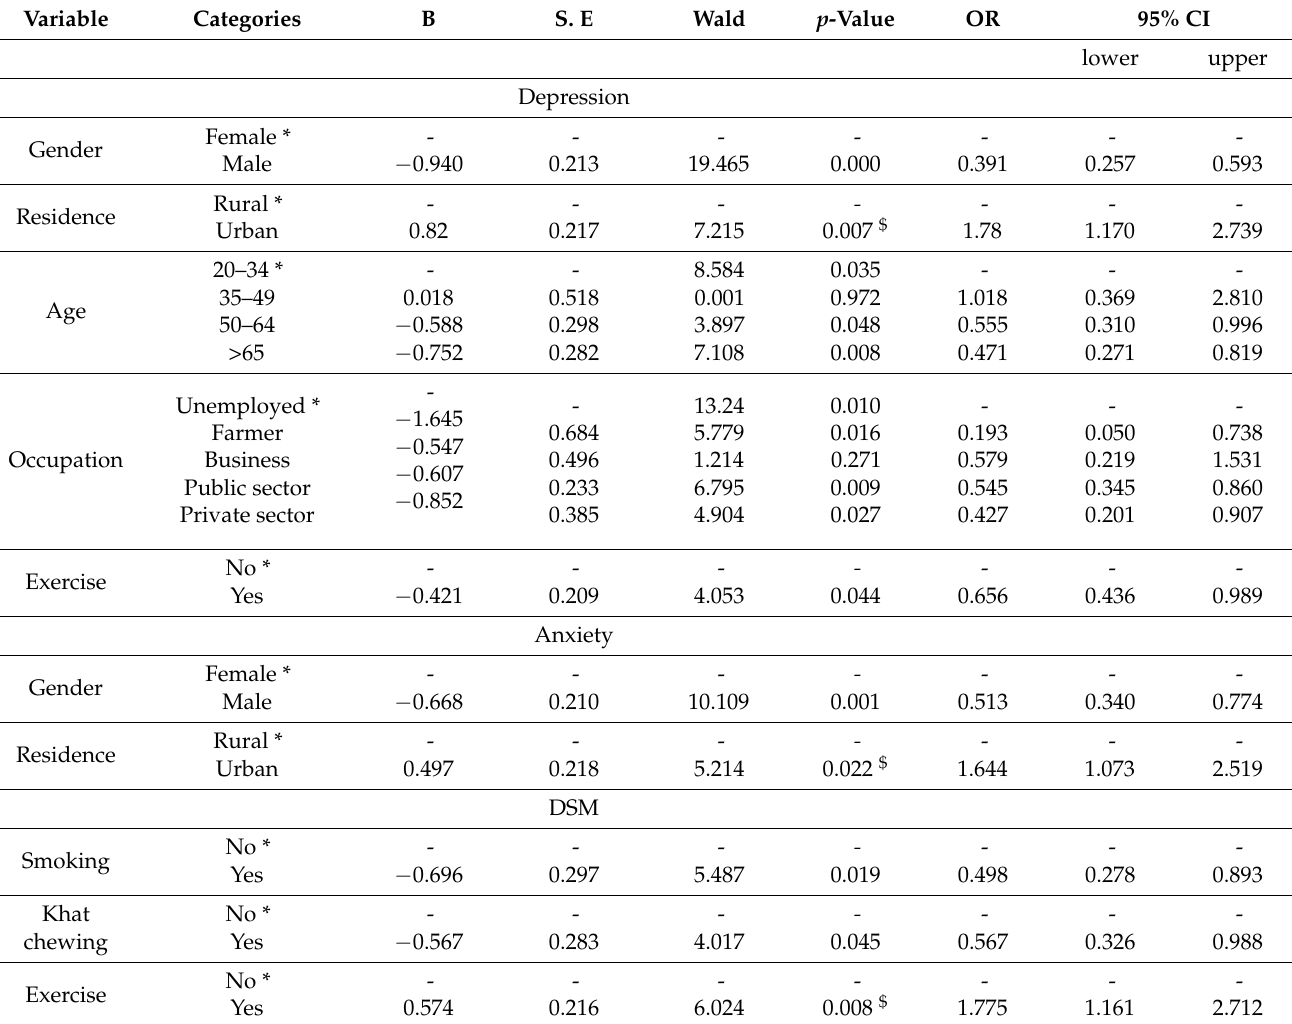
Table 6. Logistic regression model predicting depression, anxiety, and diabetes self-management among the